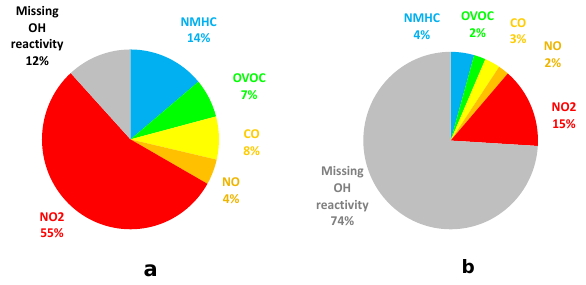
Figure 1112. The Breakdown of the total OH reactivity for a) period II and b) period III. Average 2 Fig. 12. The Breakdown of the total OH reactivity for (a) period II total OH reactivity values were respectively 18.8 s -1 (a) and 63.3 s -1 (b) 3 and (b) period III. Average total OH reactivity values were respec- tively 18.8 s − 1 (a) and 63.3 s − 1 (b) .